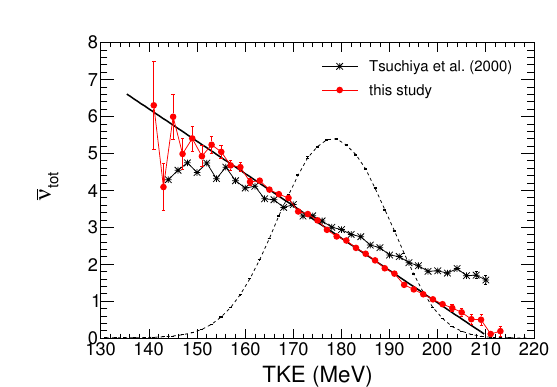
Figure 4. Average prompt neutron multiplicity per fission as a function of the heavy fission fragment mass. Data obtained in this study is compared to data from literature [17, 19]. The dot- ted black line shows the shape of the fission fragment mass dis- tribution (without absolute